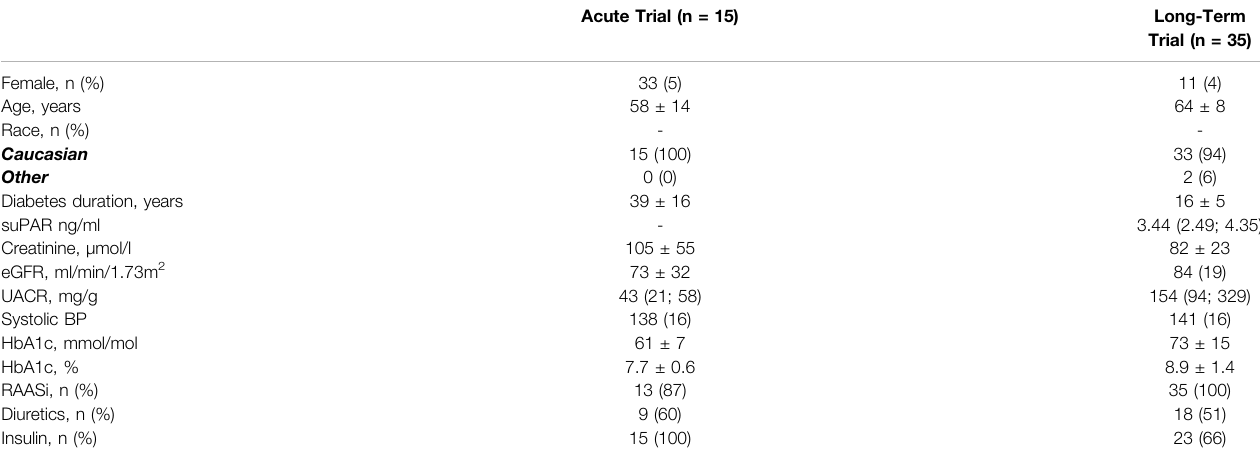
TABLE1| Baselinecharacteristicsofparticipantsintheacuteandlong-termtrials.Dichotomousvariablesarepresentedasn(%),continuousasmean±SD,andnon-normal continuous variables as median (inter-quartile range). SuPAR values were not measured at baseline in the acute trial. HbA1c: Glycated hemoglobin; eGFR: estimated glomerular fi ltration rate; BP: blood pressure; UACR: urinary albumin creatinine rate; suPAR: soluble urokinase plasminogen activator receptor; RAASi: renin-angiotensine- aldosterone system